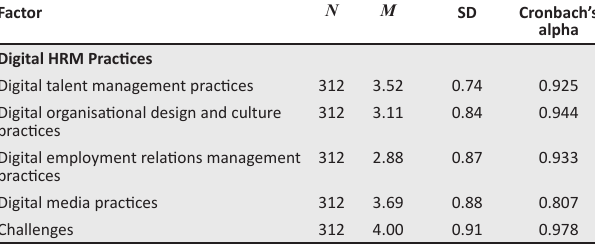
TABLE 2: Descriptive statistics for the factors. Factor N M